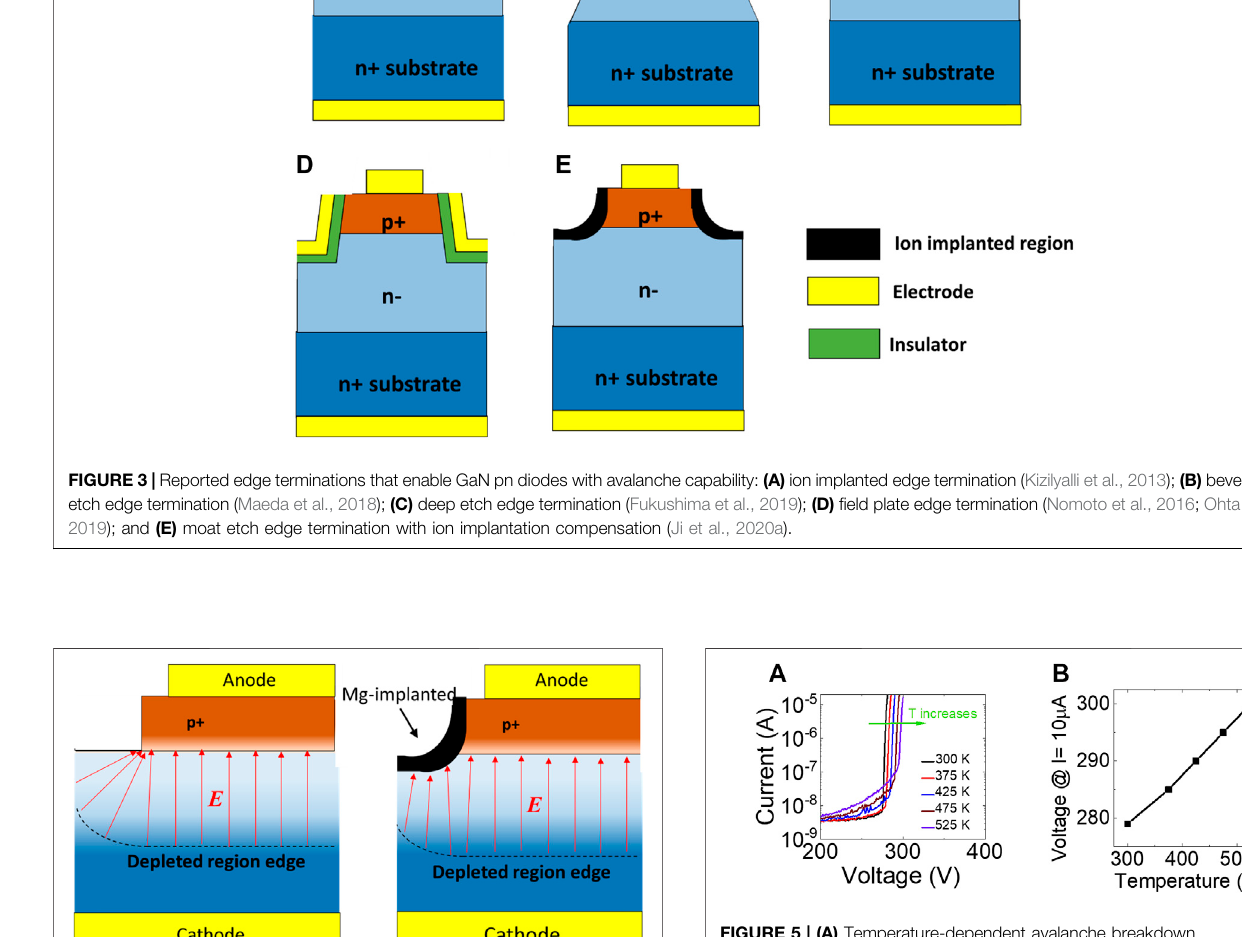
FIGURE 5 | (A) Temperature-dependent avalanche breakdown characteristics of a GaN APD; and (B) the breakdown voltage as a function of temperature. The breakdown voltage was de fi ned as the applied voltage that the current reaches 10 µA. This fi gure is reprinted from AIP